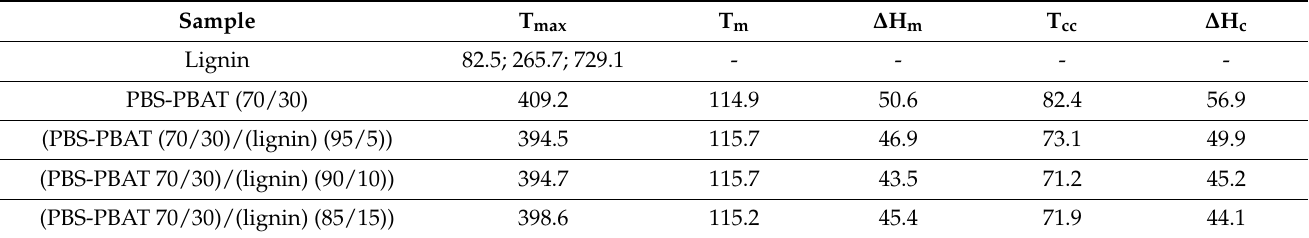
Figure 3. ( a ) TGA and ( b ) DTG curves of the lignin, biopolymer blend, and composites. Table 4. Thermal characterization of the blends and their composites from TGA and DSC.